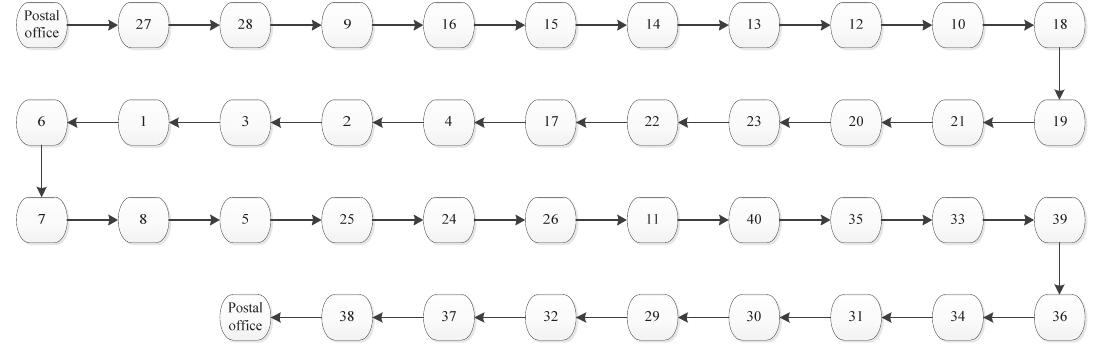
Fig. 4. The driver's considered route for servicing customers